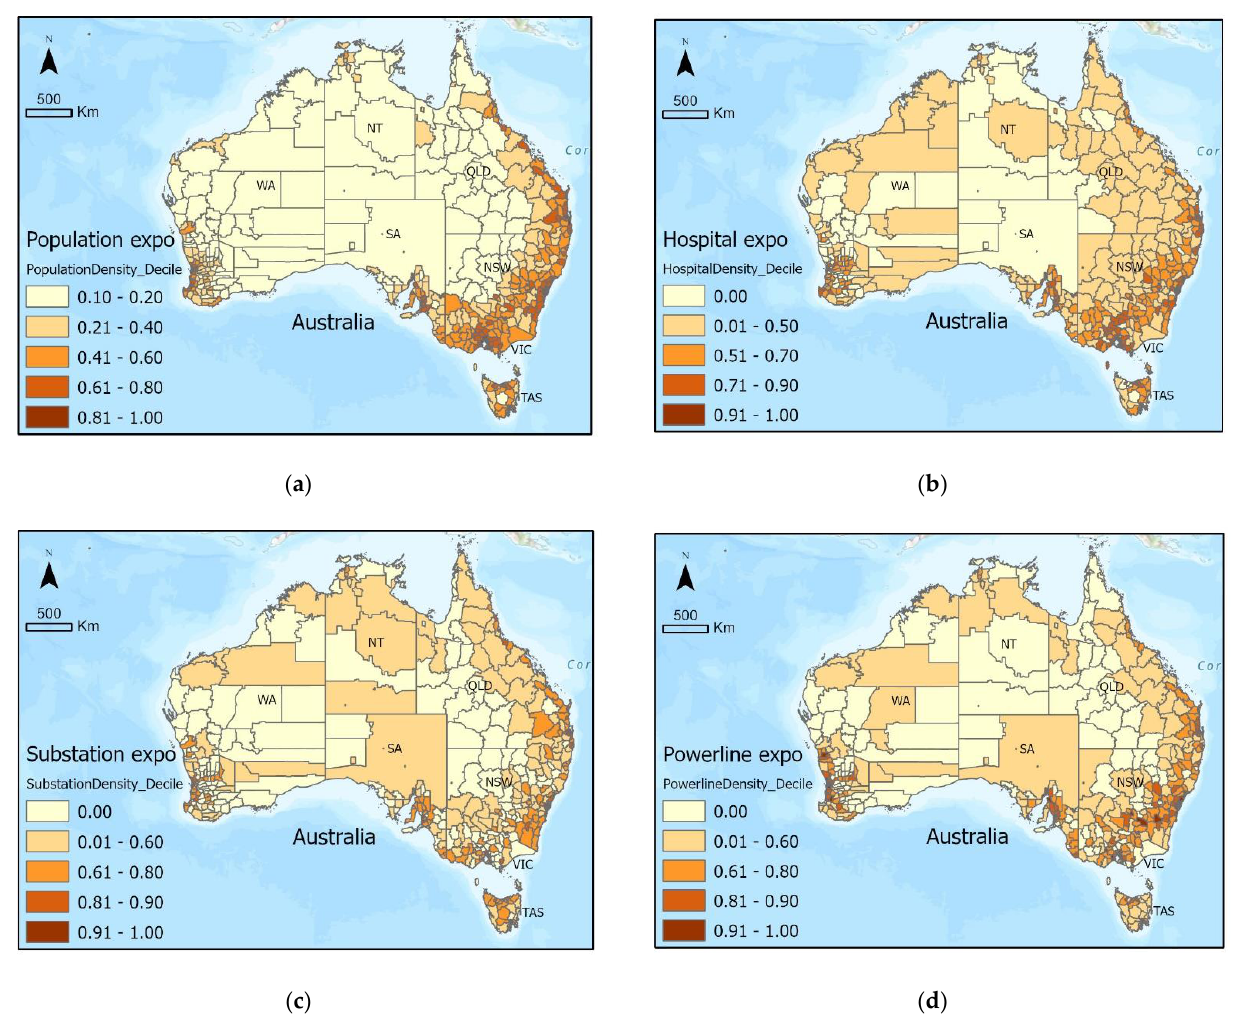
Figure 6. Exposure indicator maps of population ( a ), hospital ( b ), substation ( c ), and powerline ( d ) density.